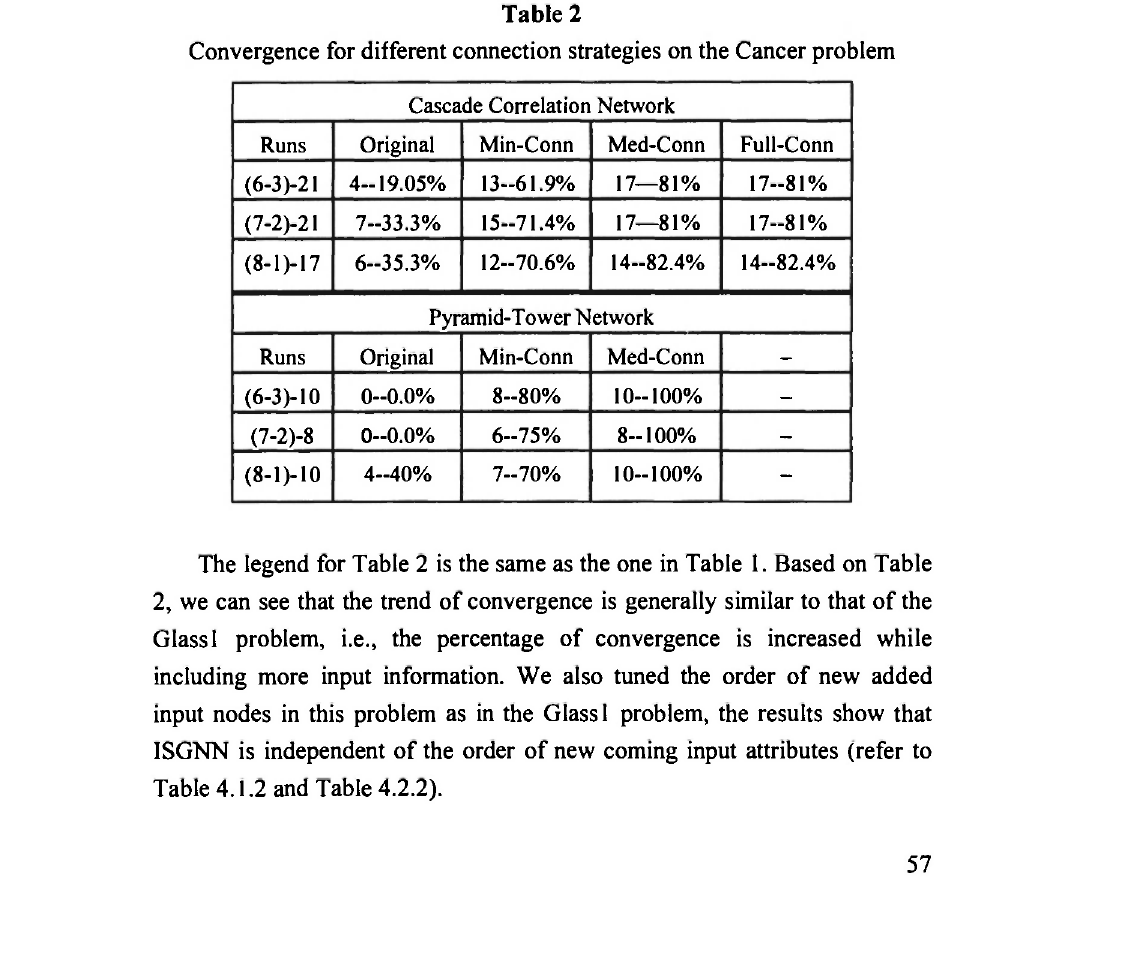
Fig. 4.2: Performance for the Cancer 1 benchmark using P-T